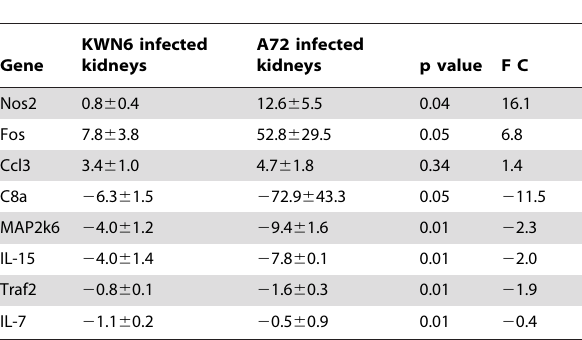
Table 2. Inflammatory gene expression in